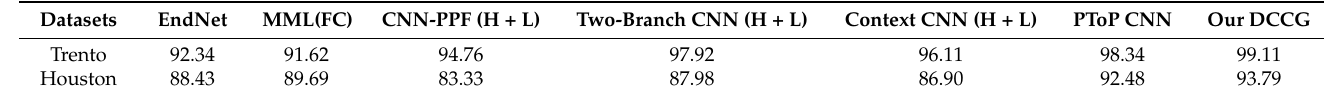
Table 7. Comparison with state-of-the-art methods on OA (%).